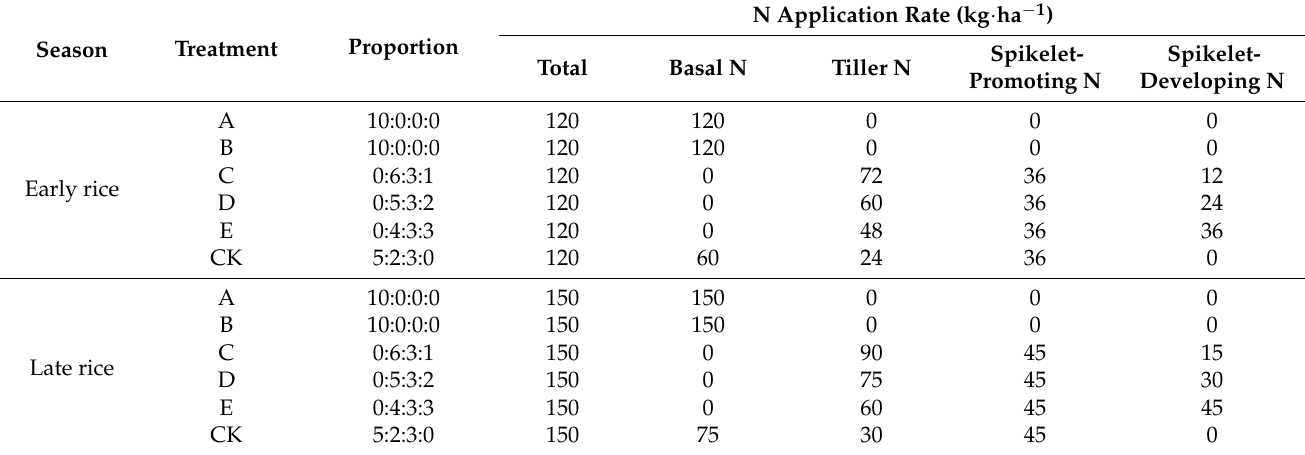
Table 3. Different nitrogen application patterns on the